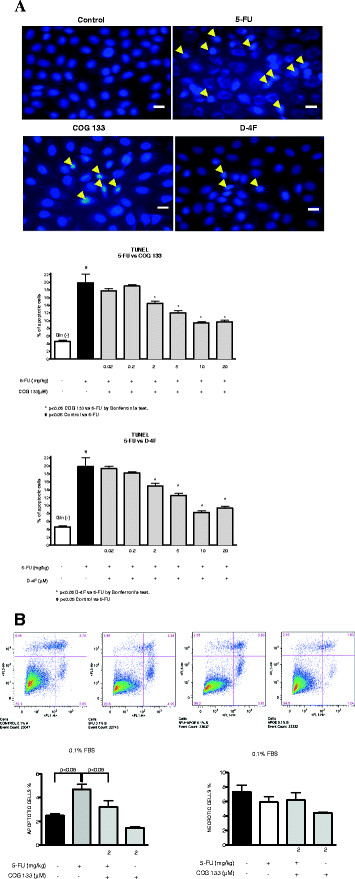
A. Terminal deoxynucleotidyl transferase-mediated dUTP nick end-labeling (TUNEL) analysis of apoptosis in IEC-6 cells were analyzed under 5% fetal bovine serum and exposed to 5-FU, with either ApoE (COG 133) or ApoA-I (D-4F) peptide treatment. Cells were stained using DeadEnd Fluorometric Tunel kit (head arrows). The Tunel System measures the fragmented DNA of apoptotic cells by catalytically incorporating fluorescein-12-dUTP at 3′-OH DNA ends using the enzyme TdT (Terminal deoxynucleotidyl Transferase). Data are plotted as mean TUNEL-labeled cells under high magnification (X400). Values represent mean ± SEM and were analyzed by one-way ANOVA. B. Cell necrosis and apoptosis were analyzed with flow cytometry in 1% fetal bovine serum and exposed to 5-FU with ApoE COG 133 peptide treatment. Cells were stained with FITC-conjugated annexin V and propidium iodide and analyzed by flow Calibur dual laser fluorescence-activated cell sorter (FACS). Results are shown as density plots with propidium iodide vs. annexin V-FITC. Bars on the graph represent the percentage of apoptotic cells have apoptotic and necrotic cells.